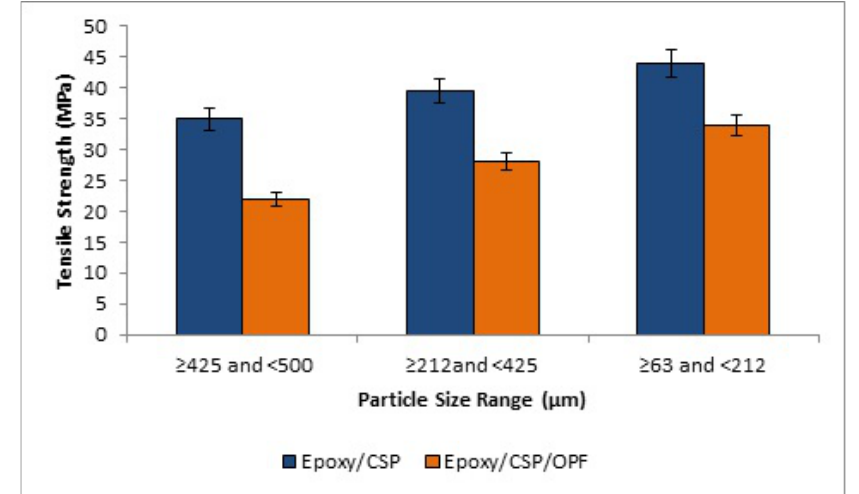
Figure 6: Tensile Strength of epoxy composites